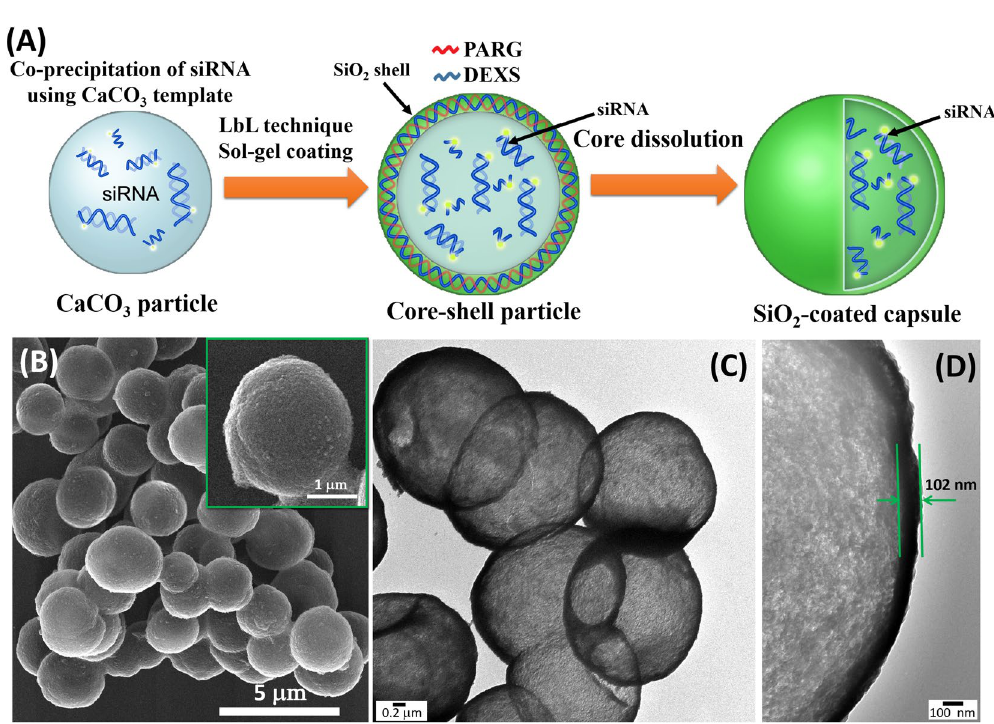
Figure 2. ( A ) The schematic illustration of the fabrication of SiO 2 -coated capsules and the encapsulation of antiviral siRNA. ( B ) SEM image of SiO 2 -coated capsules. ( C , D ) TEM images of hollow SiO 2 -coated